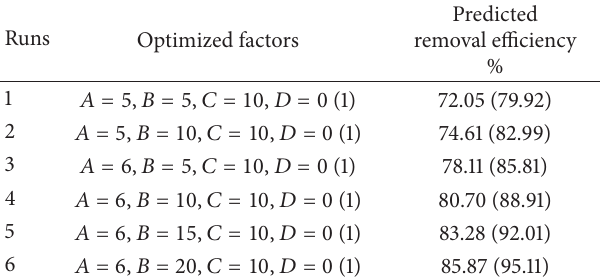
Table 6: Optimization of the analyzed